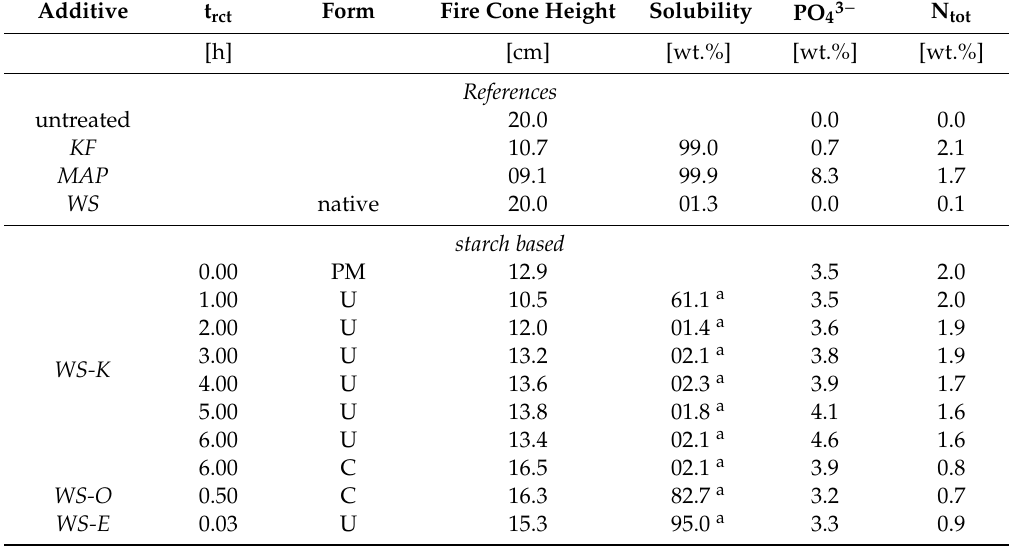
Table 2. Results of the fire tests based on ISO 11925, additive content on the wood fiber 10 wt.%. Additive t